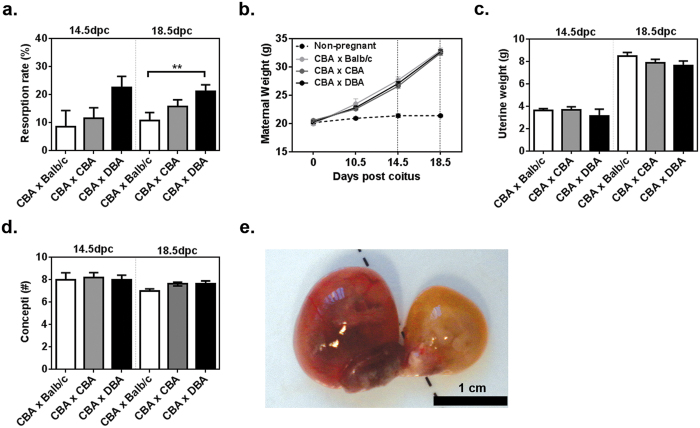
Maternal characteristics of the murine CBA/CaH × DBA/2J pregnancies.(a) Embryonic/fetal mortality (resorption) rate, (b) maternal body weight at mating, (c) uterine wet weight, and (d) number of concepti at 14.5 dpc (N = 20 dams per strain) and 18.5 dpc (N = 30 dams per strain). (e) Representative photograph of asymmetrical diamniotic/dichorionic (placentally fused) twins. All data are represented as mean ± SEM. **p < 0.01 vs value for CBA × Balb/c by One-way ANOVA with Tukey’s multiple comparison test.